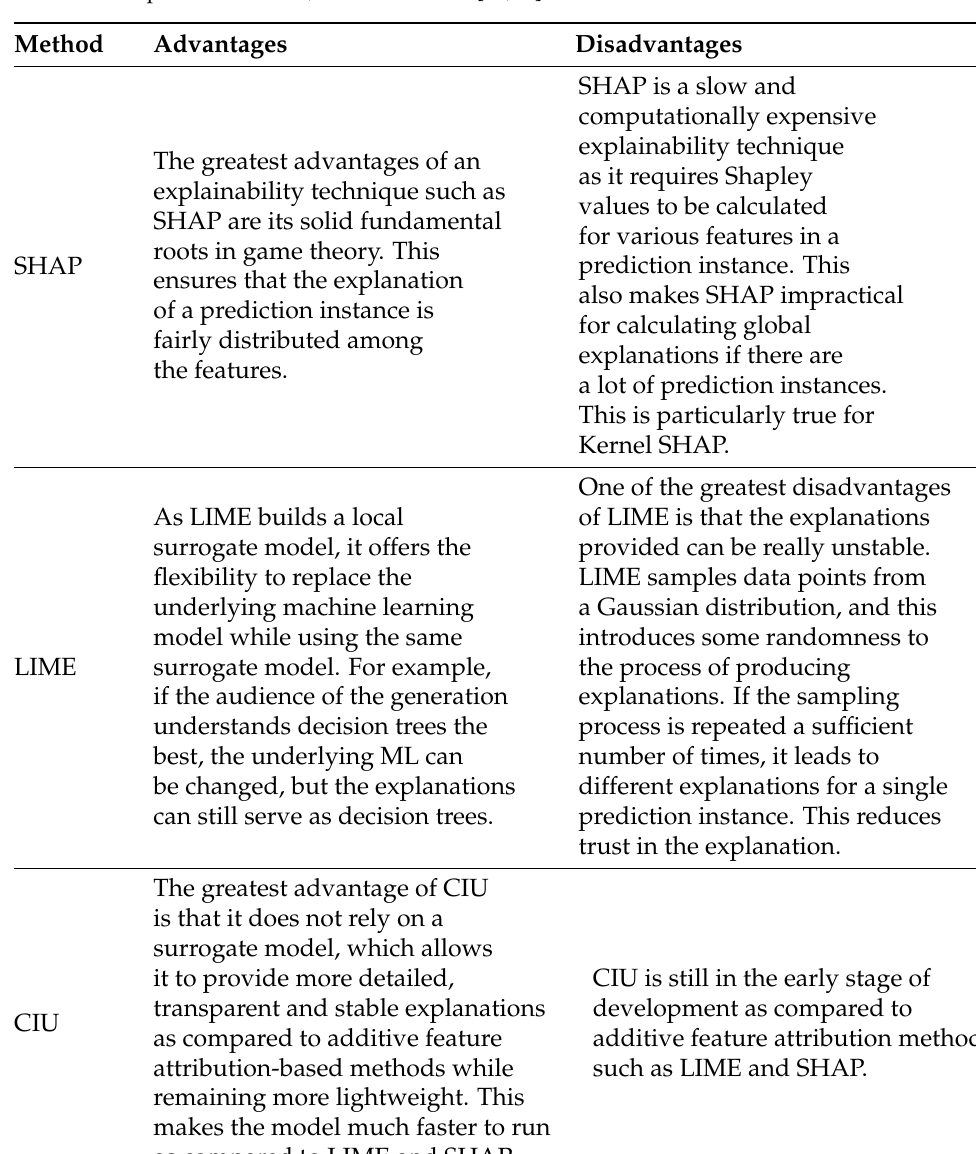
Table 1. Comparison of LIME, SHAP and CIU [40,41].